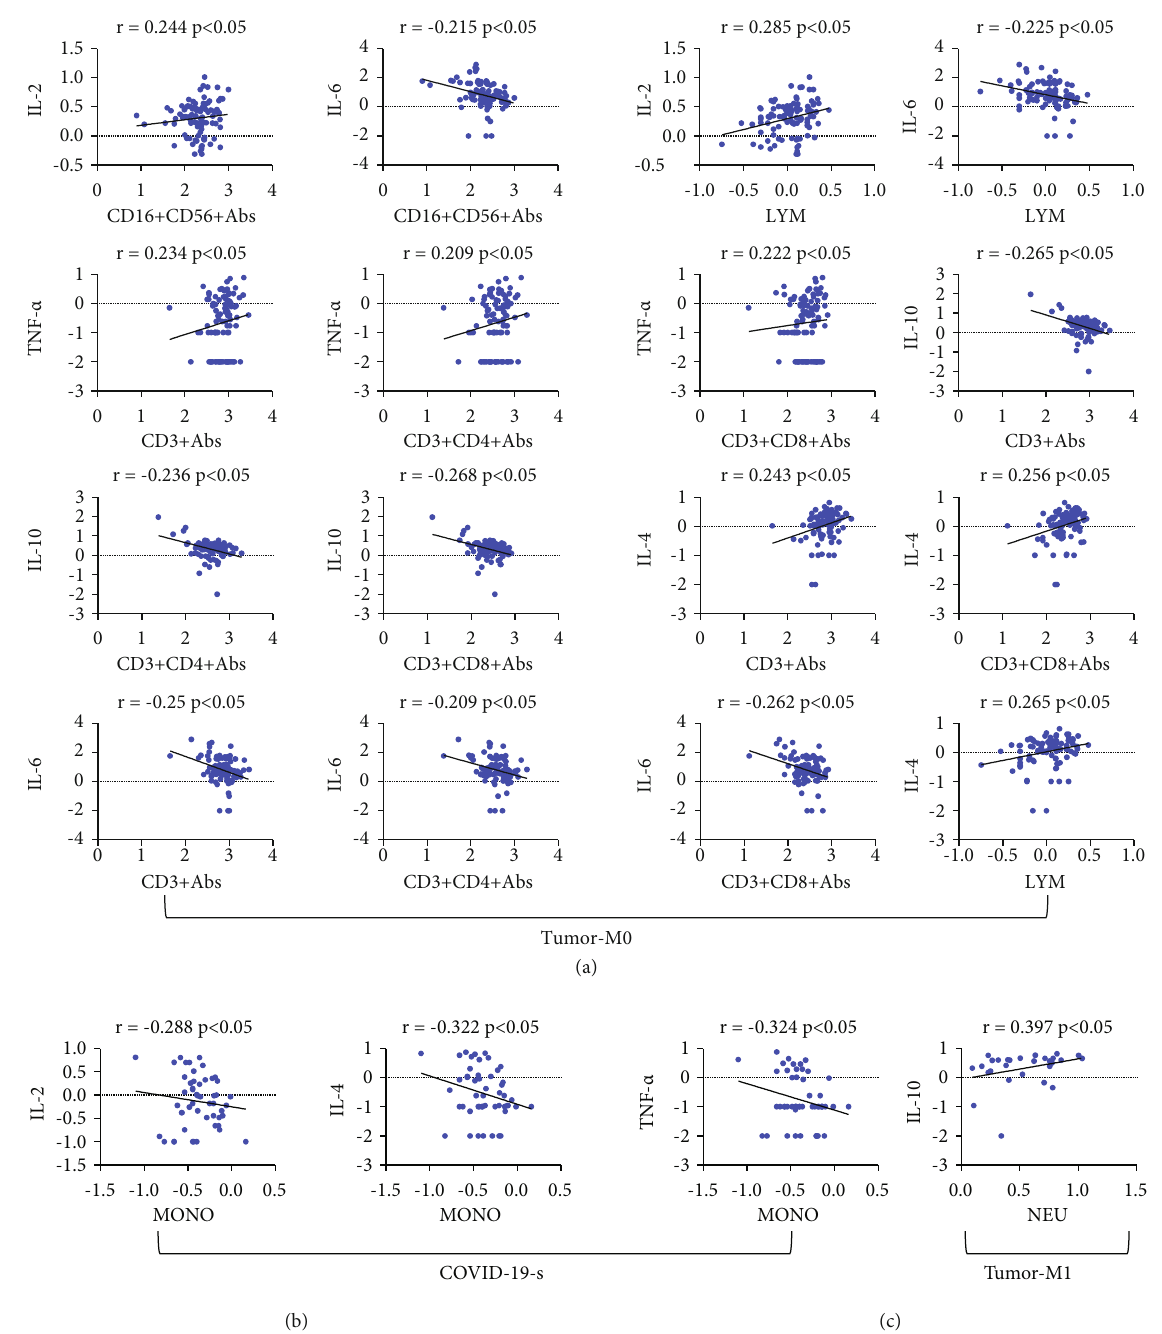
Figure 5: The correlation analysis between immune cells and cytokines of patients with COVID-19 or cancer. (a) Nonmetastatic cancer patients. (b) Severe COVID-19 patients. (c) Metastatic cancer